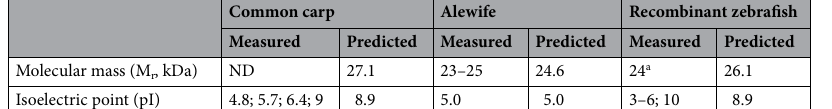
Table 1. Summary of measured biochemical characteristics of thiaminases from this study, Paenibacillus thiaminolyticus ( Pt , WP_087440168), common carp ( Cyprinus carpio ), alewife ( Alosa pseudoharengus ), and recombinant zebrafish ( Danio rerio ) putative thiaminase I protein (NP_001314821.1), and the literature, red cornetfish ( Fistularia petimba ) 27 . a ND; not determined, b By non-denaturing sodium dodecyl sulfate polyacrylamide gel electrophoresis (SDS-PAGE), c By gel filtration, d Only when not treated with heat.